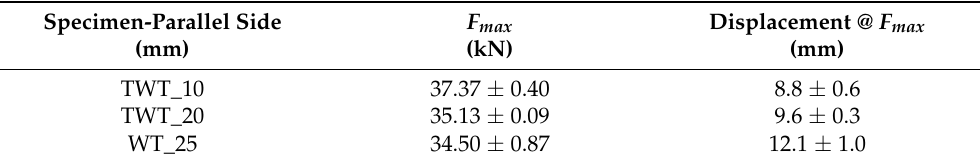
Table 7. Maximum load and corresponding displacement of Type B, 450 SDR 9 TWT, and WT